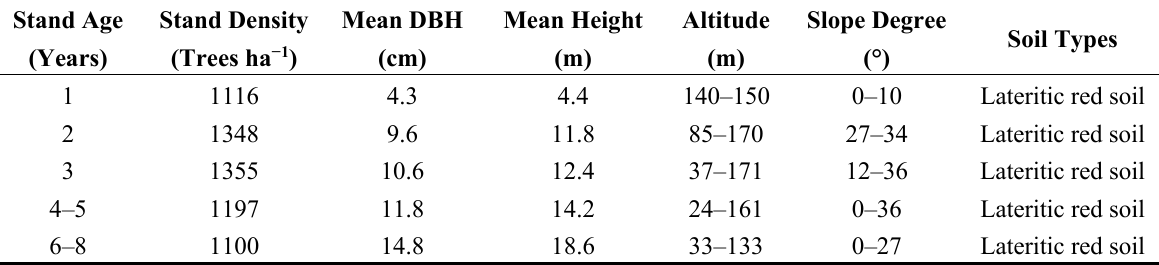
Figure 1. Map of plots in study area. Table 1. The general status of five age classes of Eucalyptus